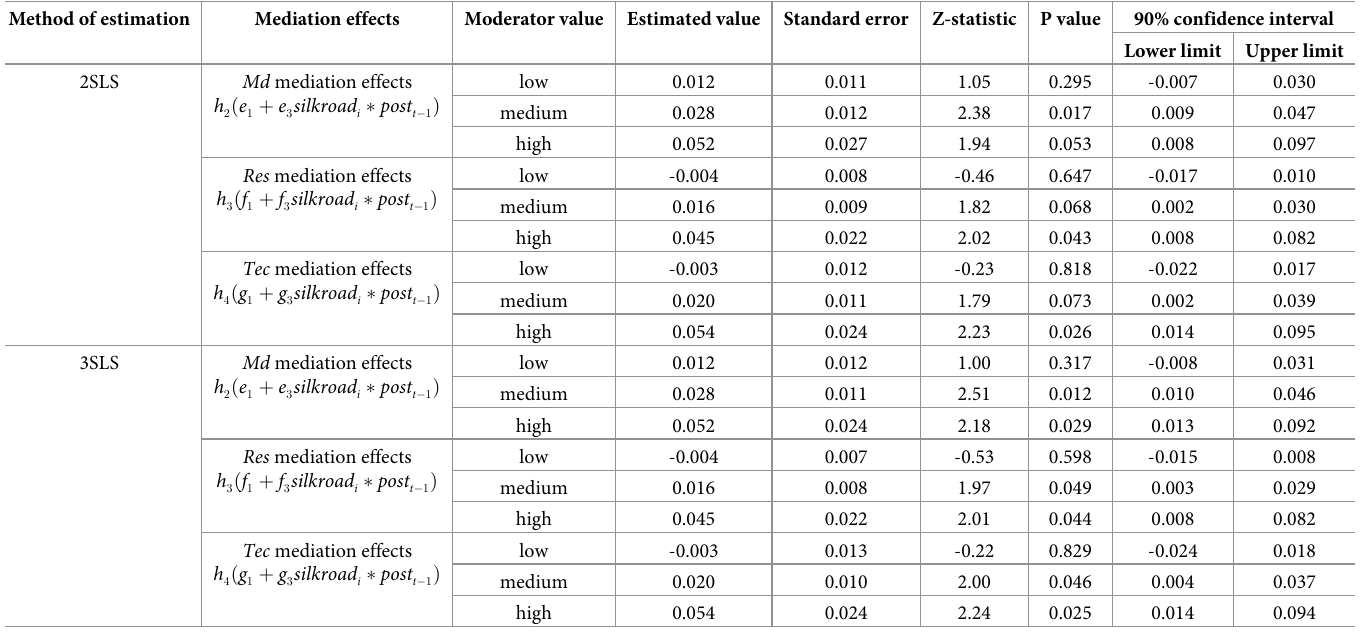
Table 12. Significance test of moderated mediation effects at different moderator values as robustness test. Method of